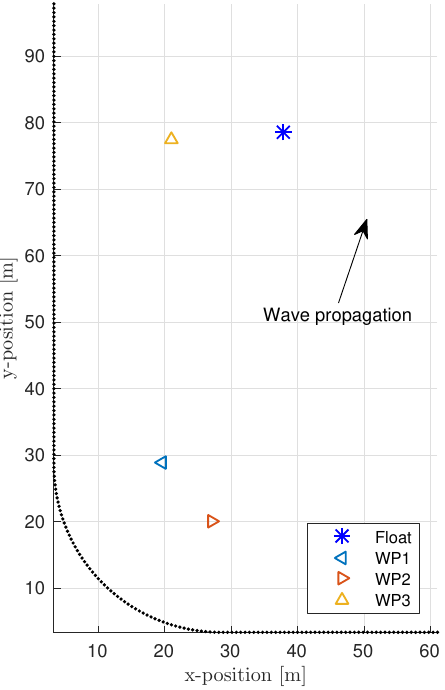
Figure 6. Basin layout for testing with locations of wave probes (“WP1”, “WP2”, and “WP3”) and test device (“Float”). Wave propagation was at 70 ◦ with respect to the x